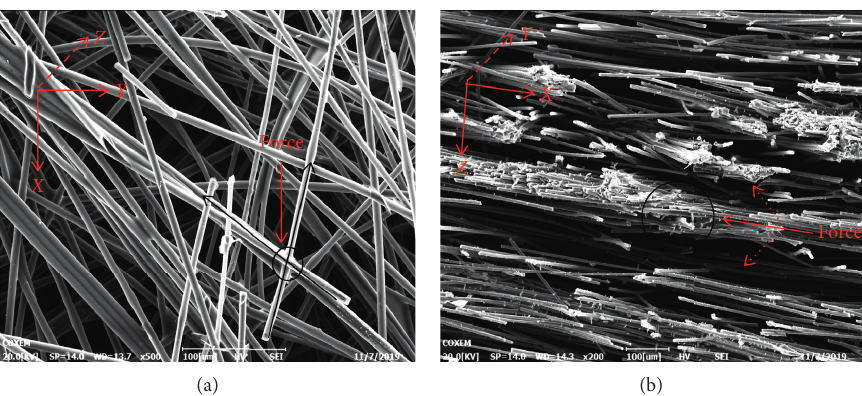
Figure 12: Compression failure mechanism diagrams of carbon/carbon fiber composites: (a) inner surface (parallel to the laminate); (b) section (vertical to the laminate).